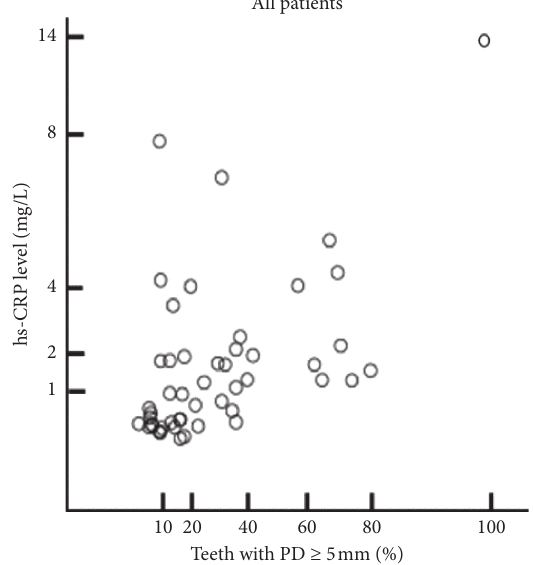
Figure 3: Matrix scatter plot of the proportion of teeth with ≥ 5mm PD and CRP concentration in all subjects. The proportion of teeth with ≥ 5 mm PD was significantly associated with CRP concentration.